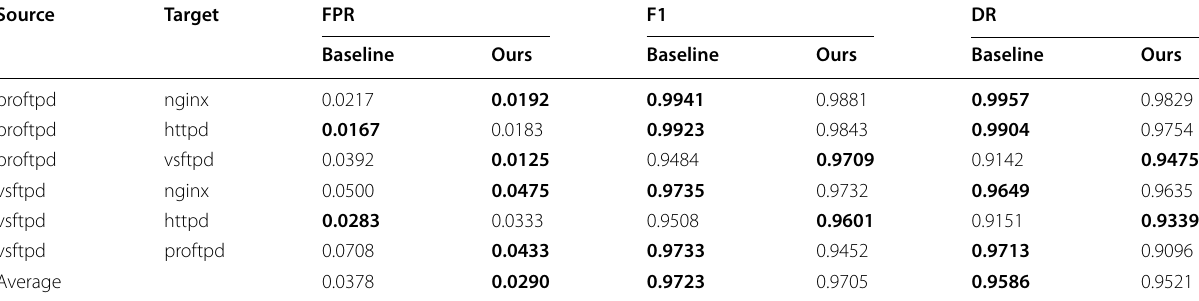
Table 3 Performance of the ROP detection on target domain programs using source domain model and domain adaptation model